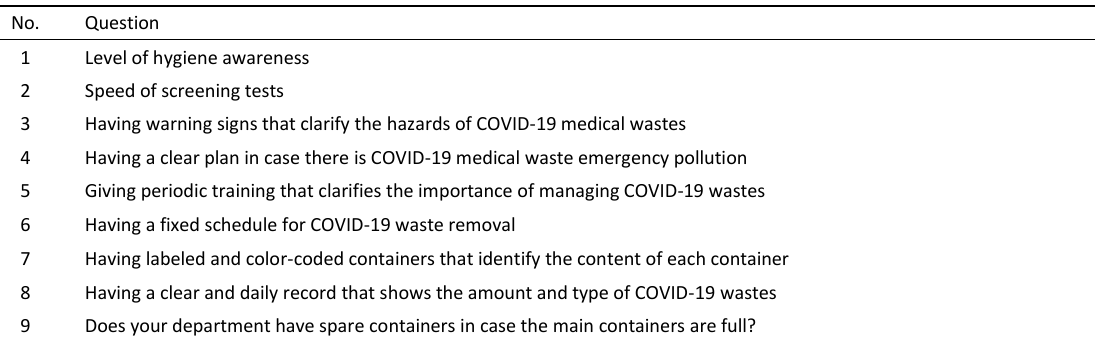
Table 2: COVID-19 medical waste administrative processes: Healthcare workers’ understanding and implementation inside COVID-19 screening stations Table 3: Healthcare workers’ knowledge and implementation of COVID-19 medical waste collection protocols